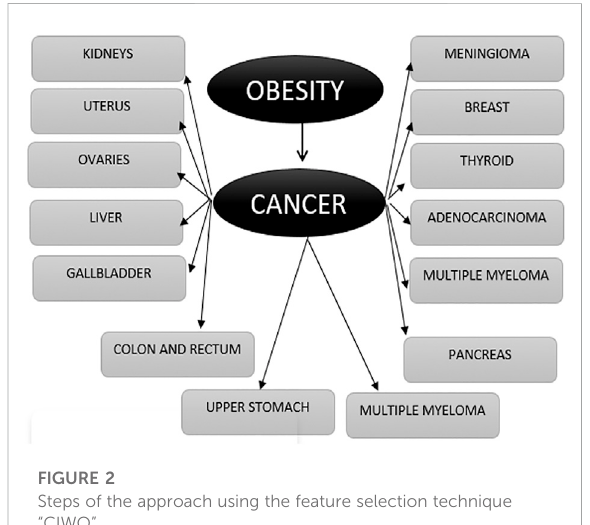
FIGURE 2 Steps of the approach using the feature selection technique “ CIWO ”